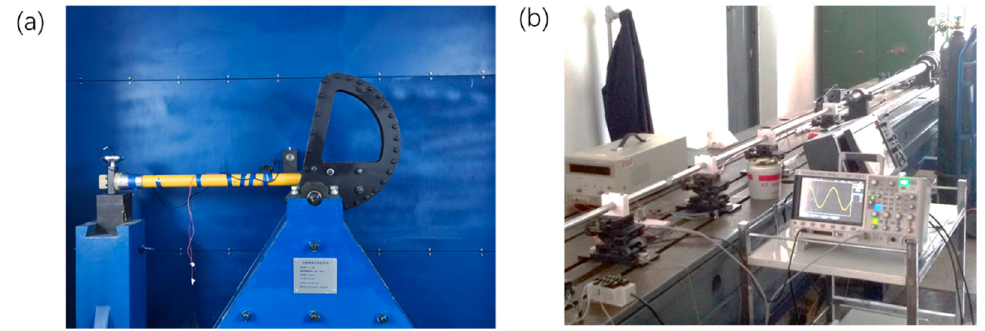
Figure 6. ( a ) Machete Hammer ( b ) Hopkinson Bar.